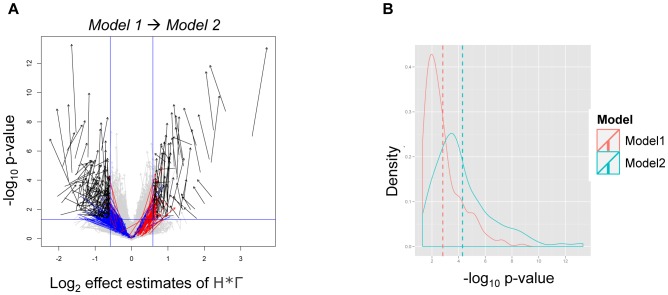
Eruption plot.A: Effect size is displayed along the x-axis at log2 scale and the y-axis shows the negative log10 p-value. The vertical blue lines indicate 1.5 fold up and down-regulation and the horizontal blue line indicates a significance of 0.05 after Bonferroni adjustment. They bound the regions of biological interest (ROI), which are characterized by a sufficiently high effect, and a sufficiently low p-value. I.e., biologically interesting effects are found in the top left and the top right segment of the plot. Each gene is represented by an arrow comparing the effect size and significance estimate of a covariate (the interaction covariate H∶Γ in this case) between Model 1 (arrow tail) to Model 2 (arrow head). The details of Models 1 and 2 are given in Table 2. Black and grey arrows represent genes completely contained within ROI and excluded completely from ROI, respectively. Red and blue arrows represent genes that are located within ROI solely in Model 1 and Model 2, respectively. B: Density plot of the p-values of Model 1 (red) and Model 2 (green). The dashed lines indicate the median of each density.